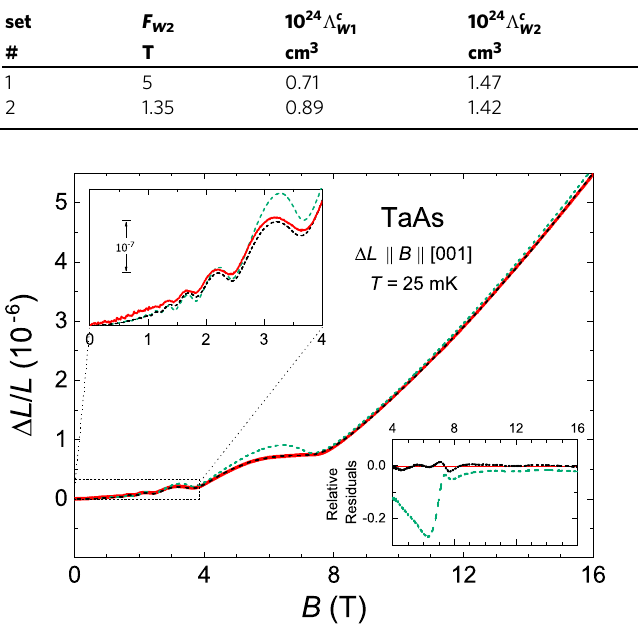
Fig. 5 Comparison of the calculated magnetostriction for the case of F = 1.35 T with the experimental data for TaAs. The solid red line W 2 shows the c -axis magnetostriction Δ L / L of TaAs measured at T = 25 mK and B ∥ c . The dashed green and black lines have the same meaning as in Fig. 3, but they are calculated for set 2 in Table 1. The upper inset is a zoom into the low- fi eld region, and the lower inset compares the appropriate relative residuals, showing a very good agreement in the entire fi eld range when ζ ( B ) is considered (dashed black line).